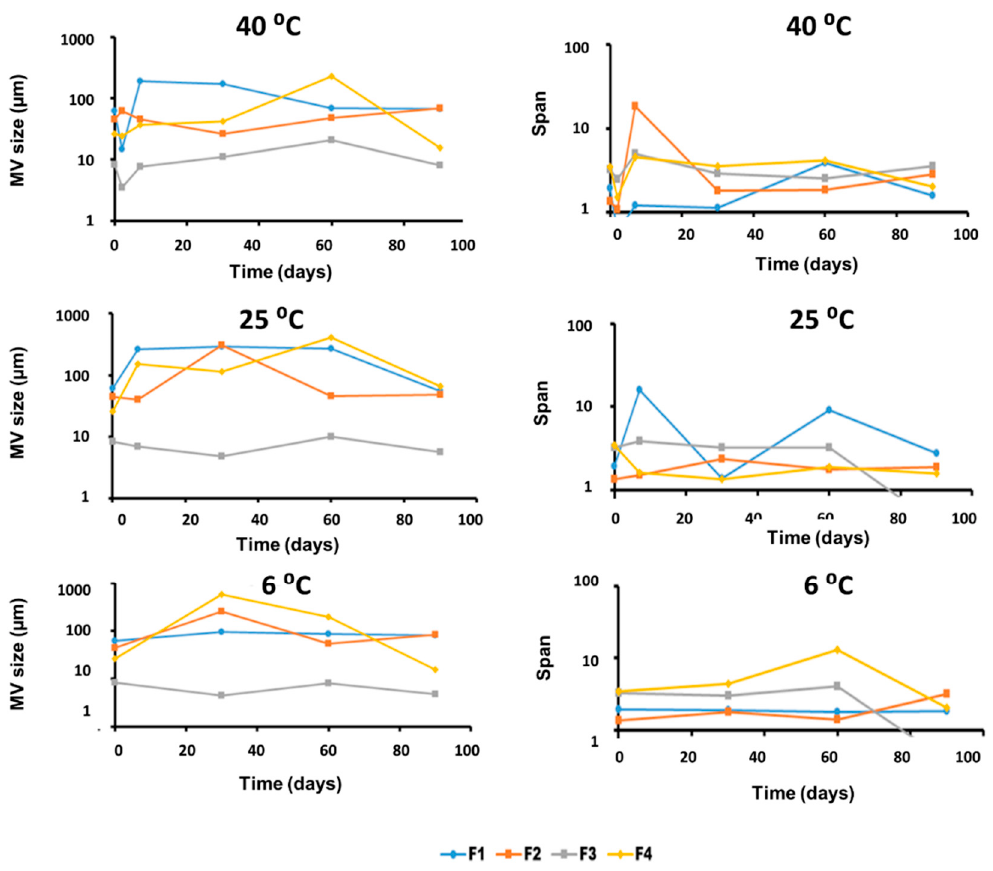
Figure 2. Evolution of MV size (left) and polydispersity of size expressed as span (right) of samples stored at different temperatures in semilogarithmic scale.